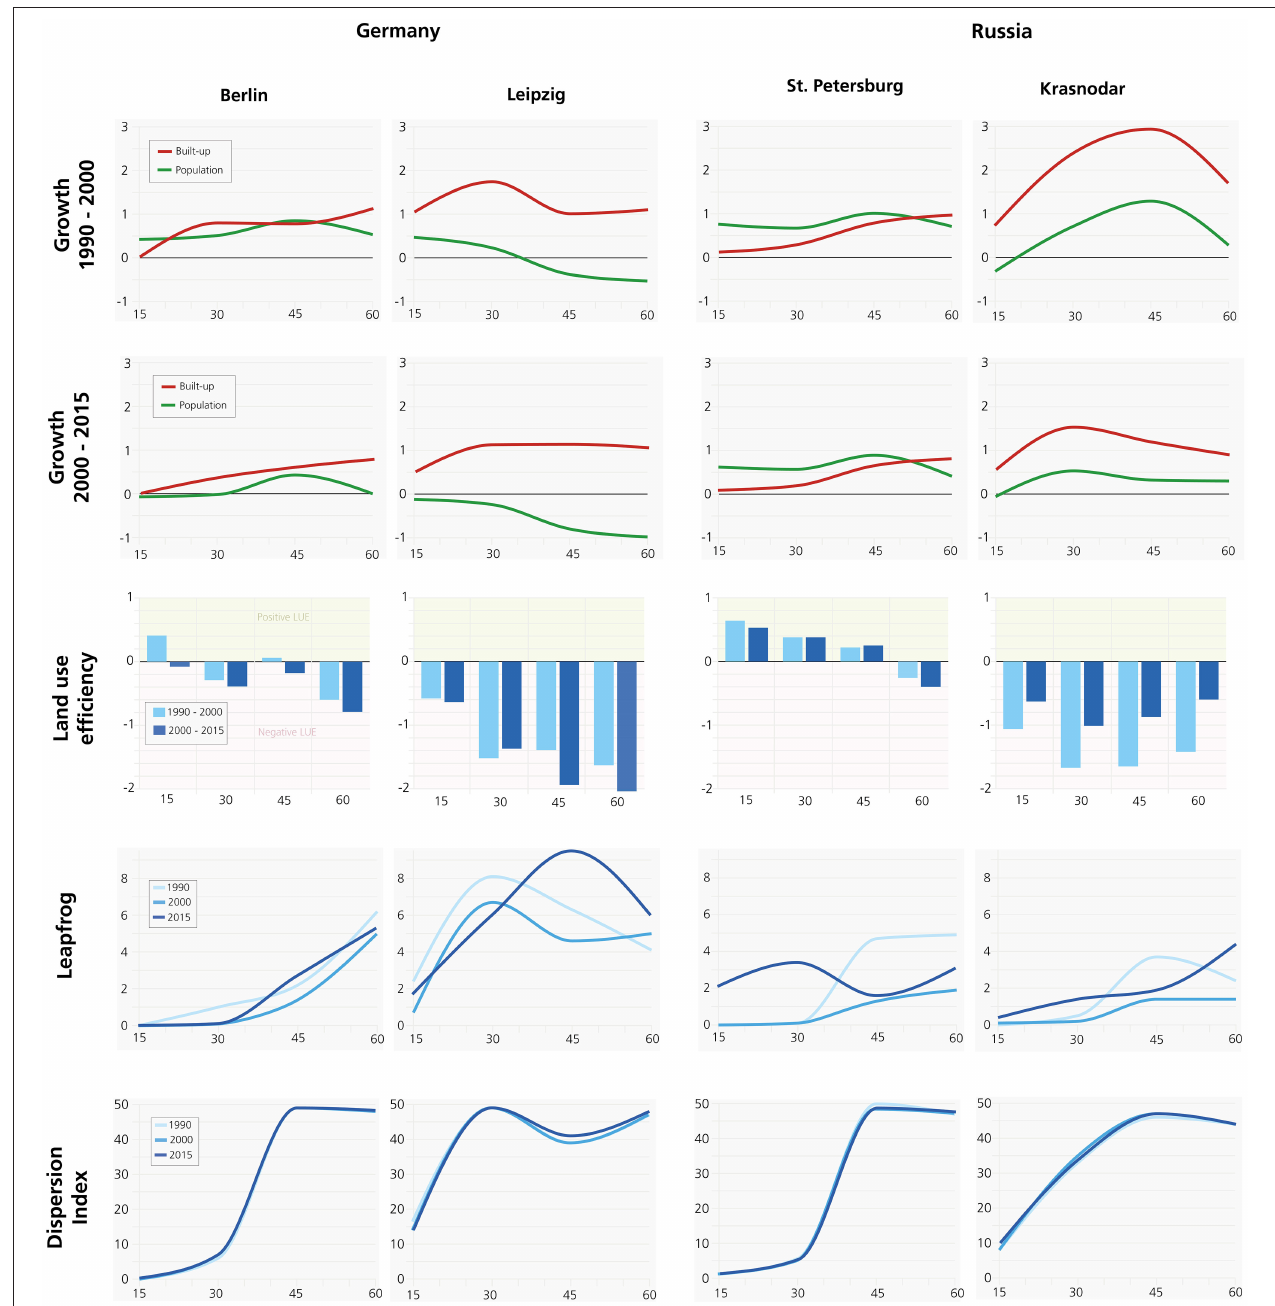
FIGURE 6 | Urban sprawl metrics for Berlin, Leipzig, St. Petersburg and Krasnodar (Graphic: C. Gerten).